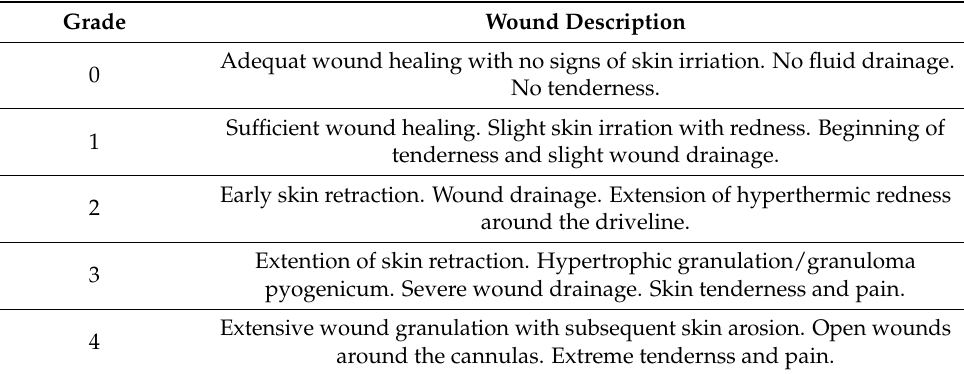
Table 3. Heidelberg driveline wound